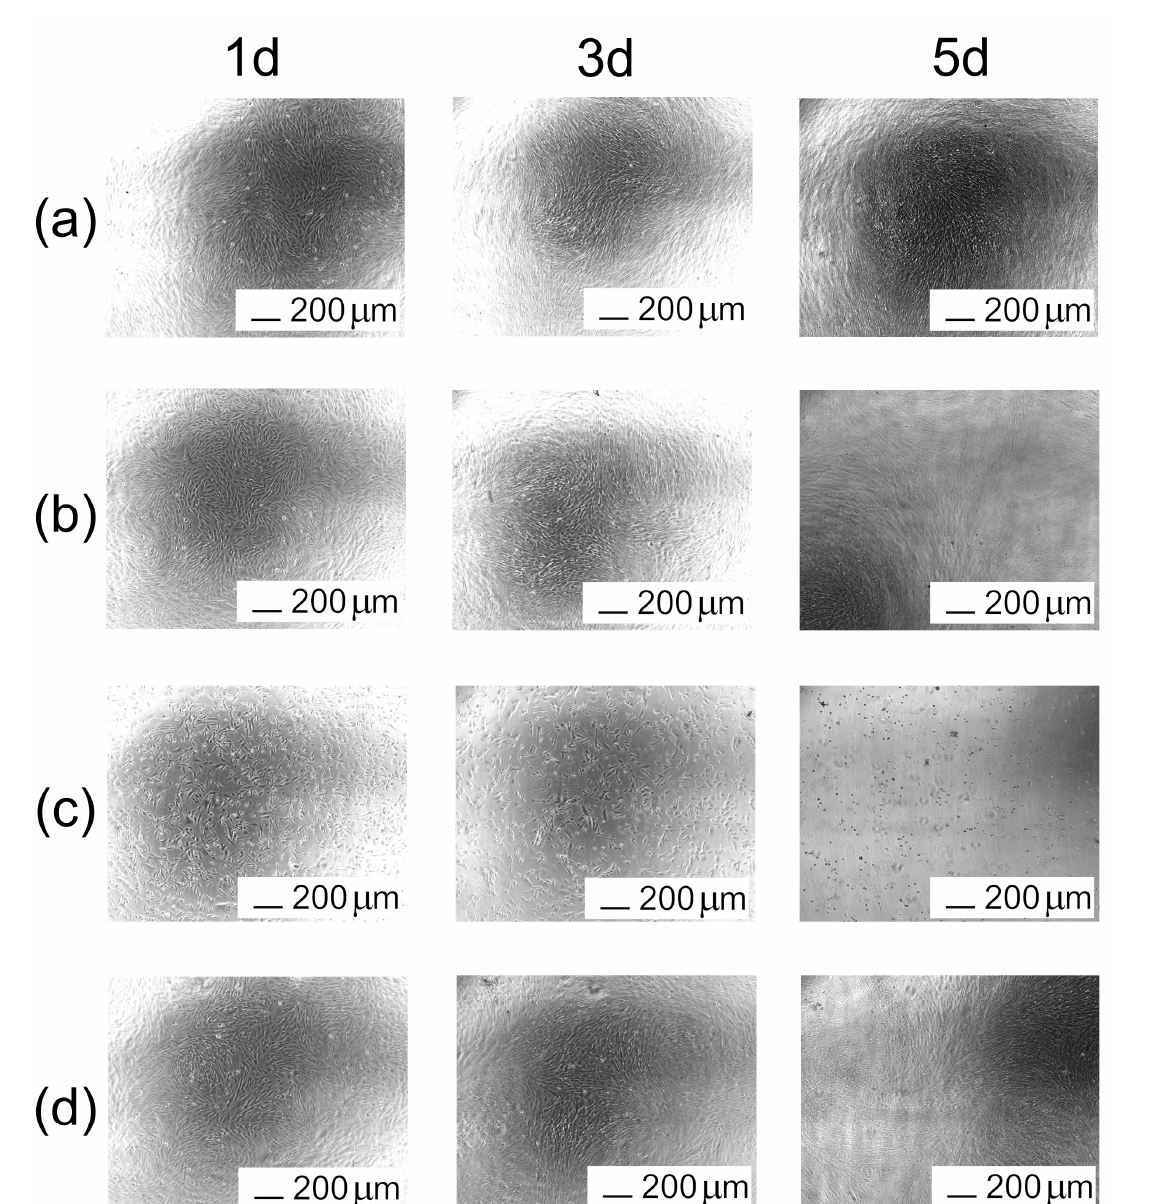
Figure 7. Morphologies of Man-1 cells cultured in the extraction media for 1, 3 and 5 days: ( a ) control, ( b ) TiNi, ( c ) Ir/TiNi, Figure 7 ( d )